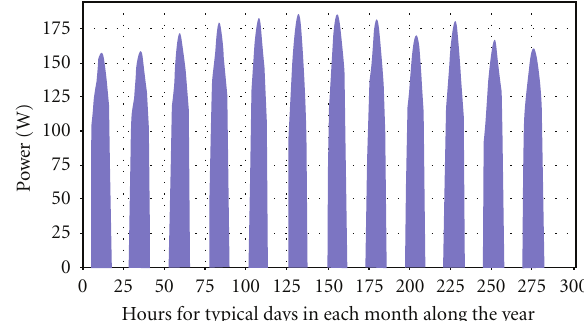
Figure 11: Relation of the extraterrestrial and the surface radiation.